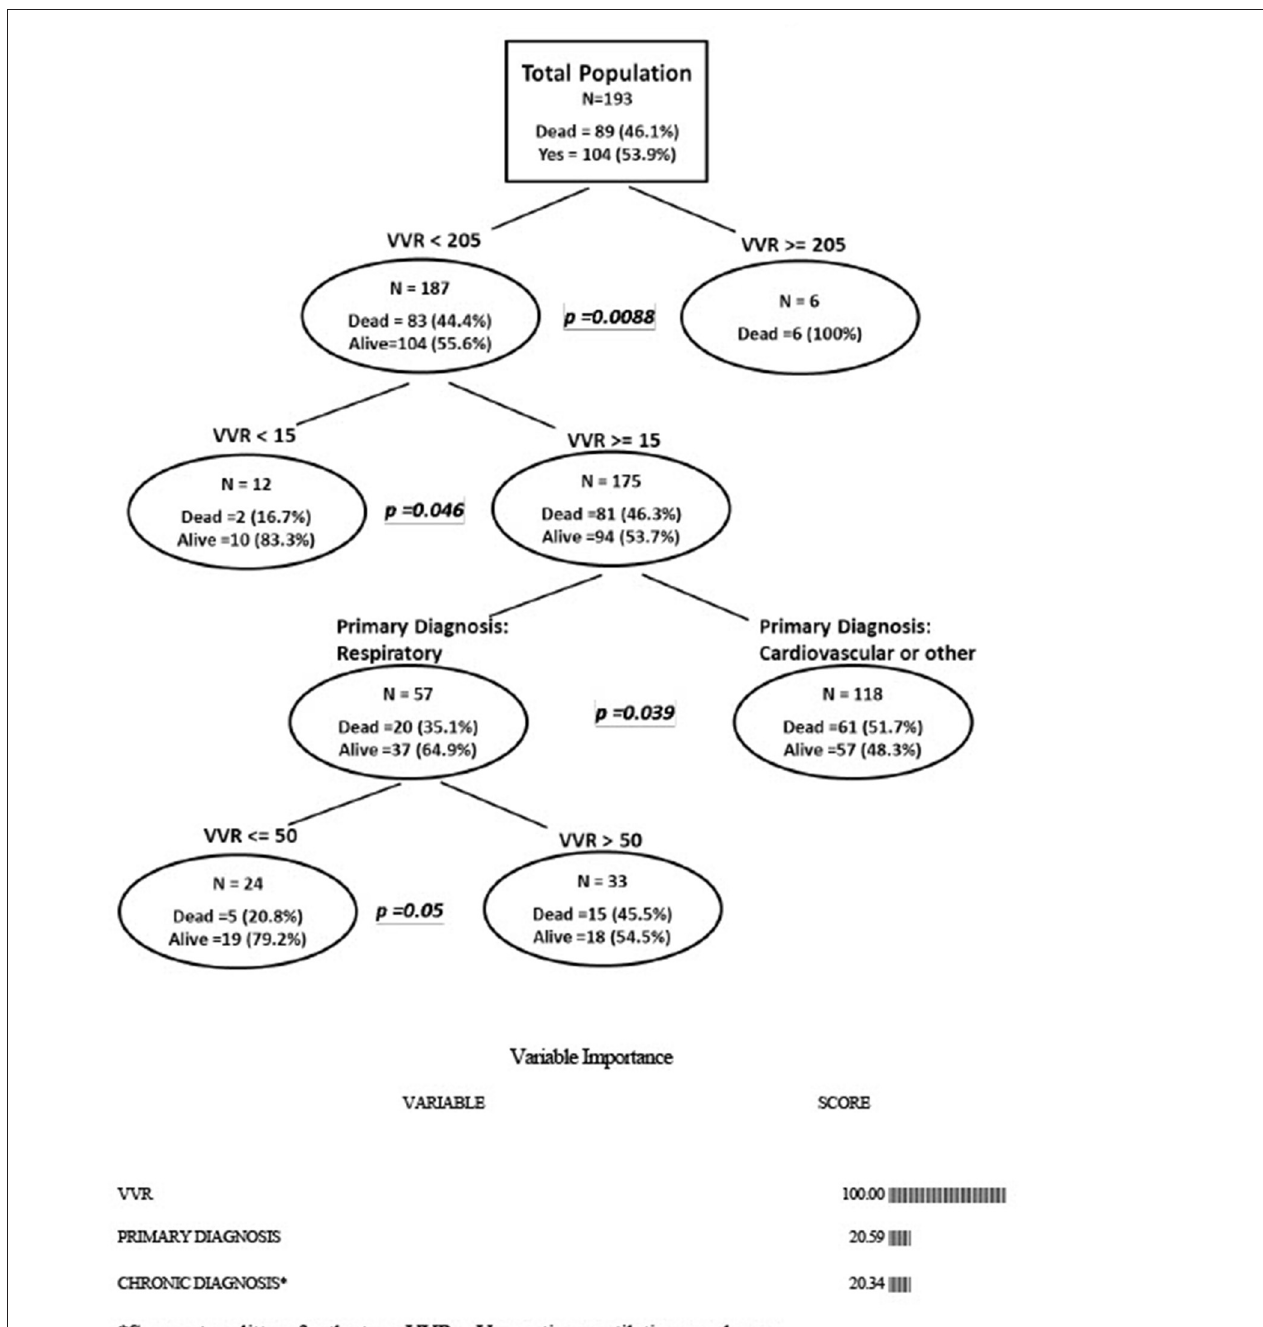
FIGURE 2 | Multivariable classification tree analysis-association of vasoactive-ventilation-renal score and other risk factors with mortality. *Surrogate splitters for the tree; VVR, vasoactive-ventilation-renal score.